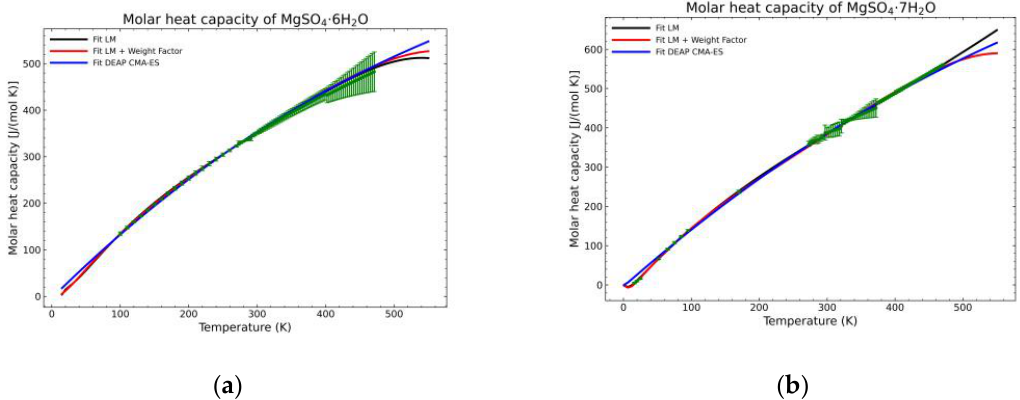
Figure 14. Comparison of the different fit results, showing the literature data in green (mean of the values) with the 95% confidence interval boundaries of: ( a ) MgSO 4 ·6H 2 O; ( b ) MgSO 4 ·7H 2 O.